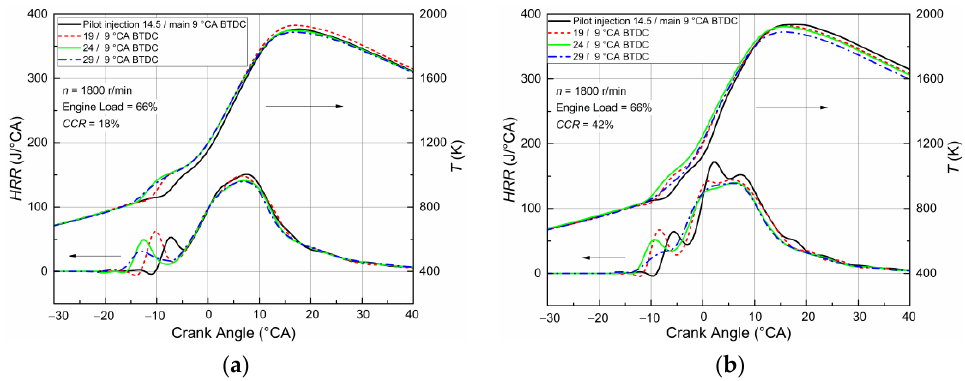
Figure 4. HRR and T under different pilot injection timings at 18% CCR ( a ) and 42% CCR ( b ).